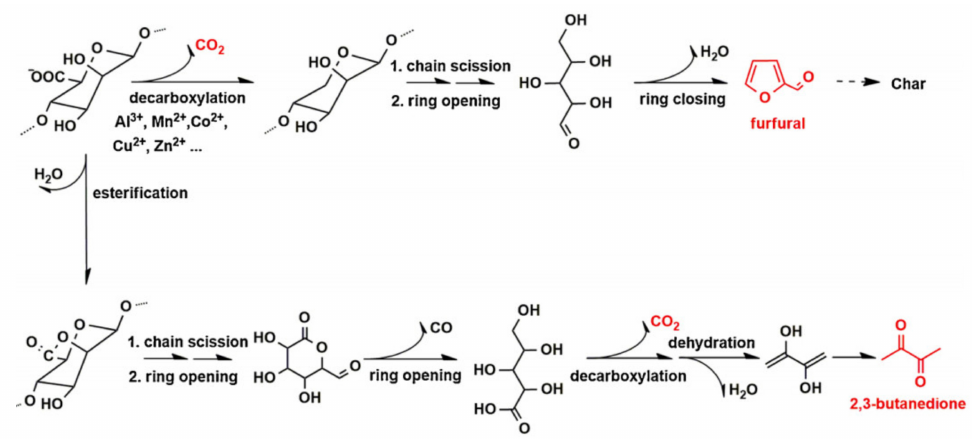
Figure 13. The proposed pyrolysis pathways of alginate